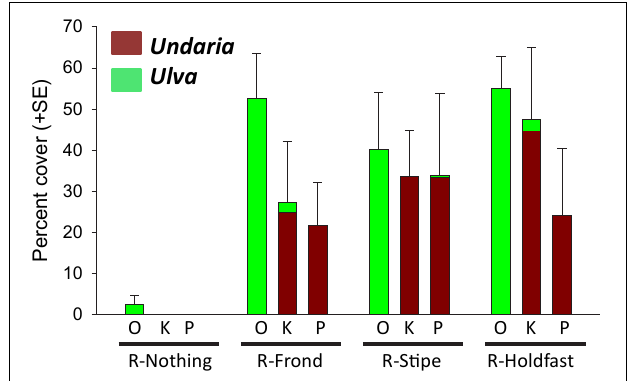
FIGURE 6 | Percent cover (+ SE) of weedy macroalgae (the non-native kelp Undaria pinnatifida and green sheet-forming Ulva spp.) 4 months after bull kelp fronds, stipes or holdfasts were removed (R) from plots in Oaro (O), Kaik (K), and Point (P) reefs ( n = 4). R-Nothing = intact control plots.